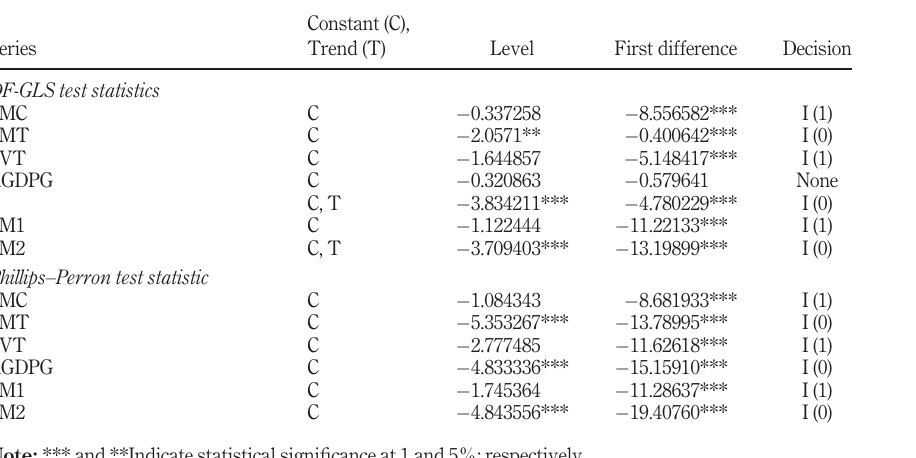
Table 3. Unit root